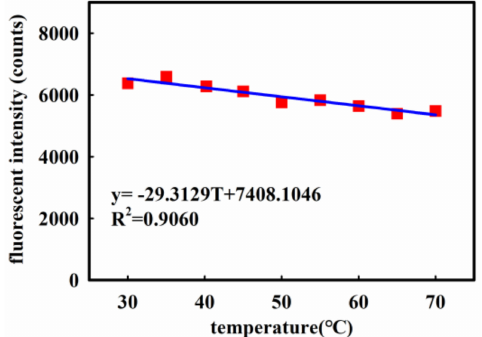
Figure 12. The response of the UVOFS versus